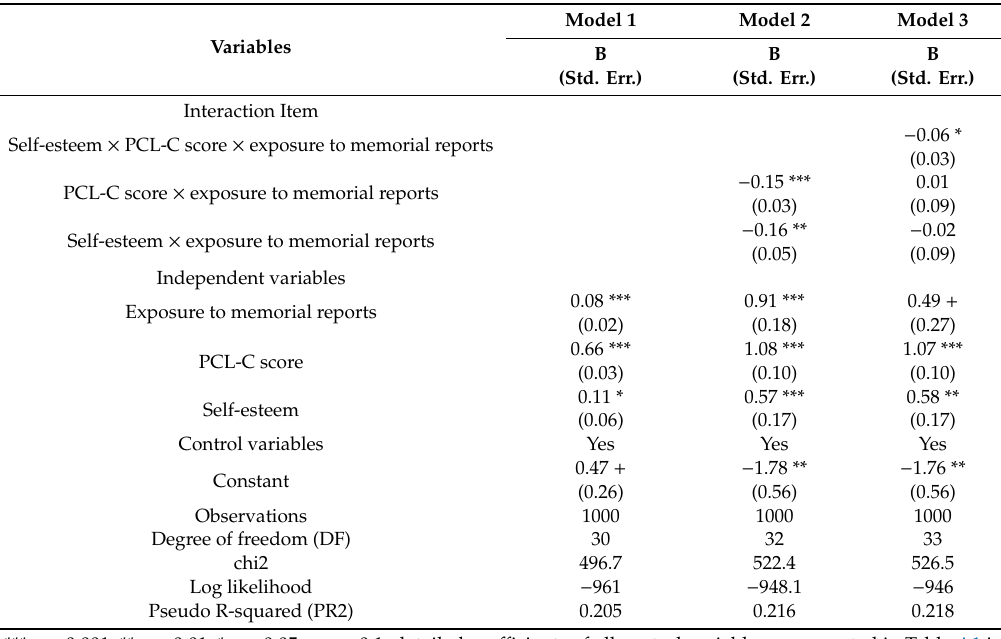
Table 2. Tobit regression model of exposure to memorial reports, self-esteem, and PTSD symptoms on post-traumatic growth inventory